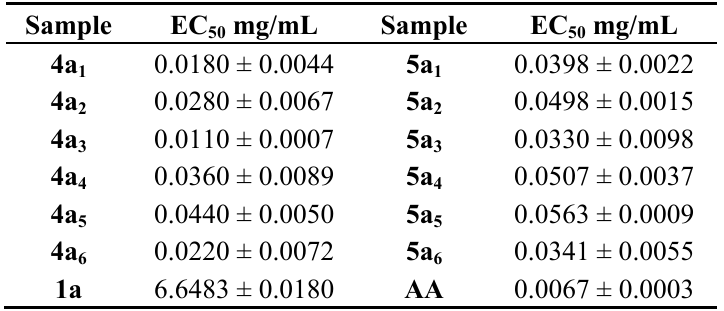
mg/mL) of the sulfadiazine derivatives 4a 50